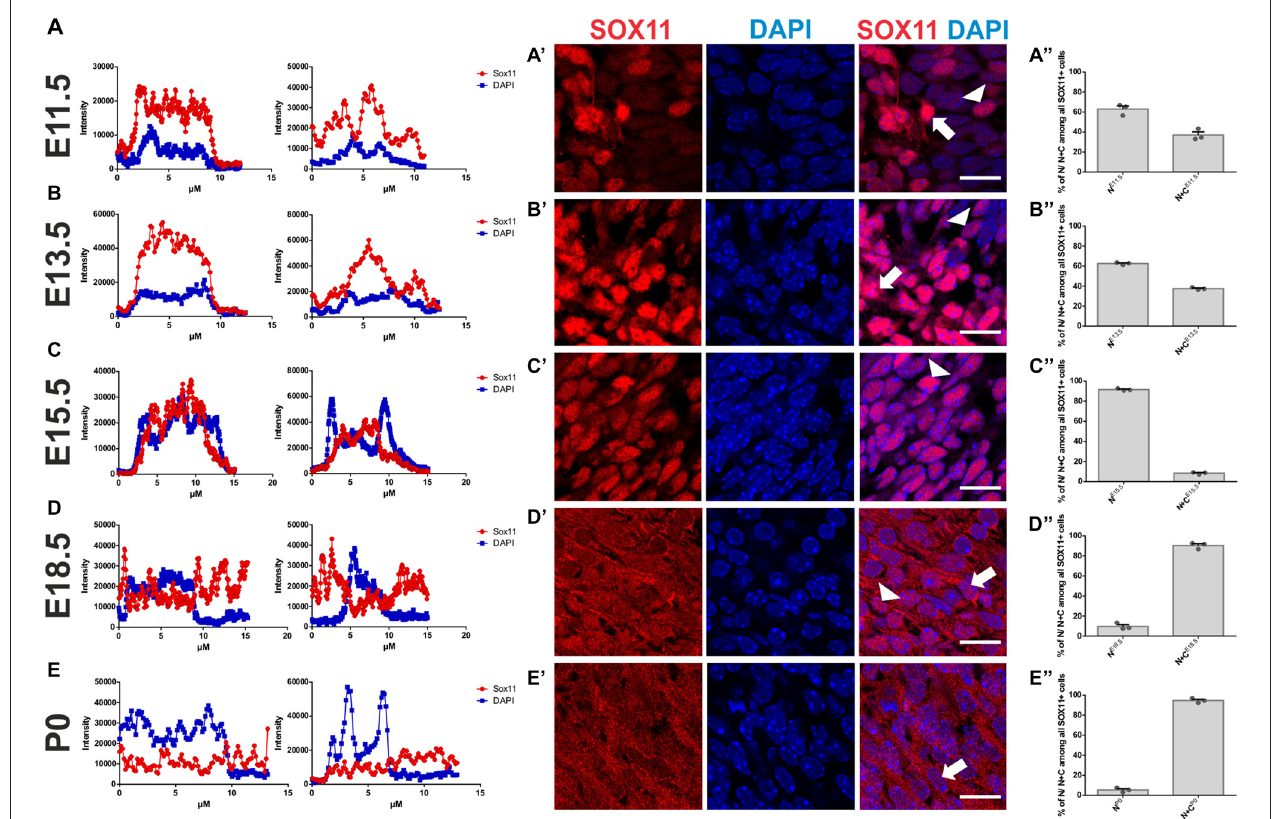
FIGURE 1 | SOX11’s subcellular localization in embryonic neurogenesis. Representative line intensity plots of cells from E11.5 (A) , E13.5 (B) , E15.5 (C) , E18.5 (D) and P0 (E) . The blue line represents intensity of DAPI, the red line represents intensity of SOX11. Coronal sections of brains derived from E11.5 (A (cid:48) ) , E13.5 (B (cid:48) ) , E15.5 (C (cid:48) ) , E18.5 (D (cid:48) ) and P0 (E (cid:48) ) mice were stained for SOX11 (RED) and DAPI (blue). Arrows: cells with nuclear and cytoplasmic localization of SOX11; arrow heads: cells with exclusively nuclear localization of SOX11. Note the almost exclusive nuclear localization of SOX11 at E15.5. Scale bars: 20 µ m. Graphs represent the percentage of cells with nuclear localization or nuclear and cytoplasmic localization of SOX11 over all the SOX11 positive cells counted from E11.5 (A (cid:48)(cid:48) ) , E13.5 (B (cid:48)(cid:48) ) , E15.5 (C (cid:48)(cid:48) ) , E18.5 (D (cid:48)(cid:48) ) and P0 (E (cid:48)(cid:48) ) . The data are presented as mean ± SEM.